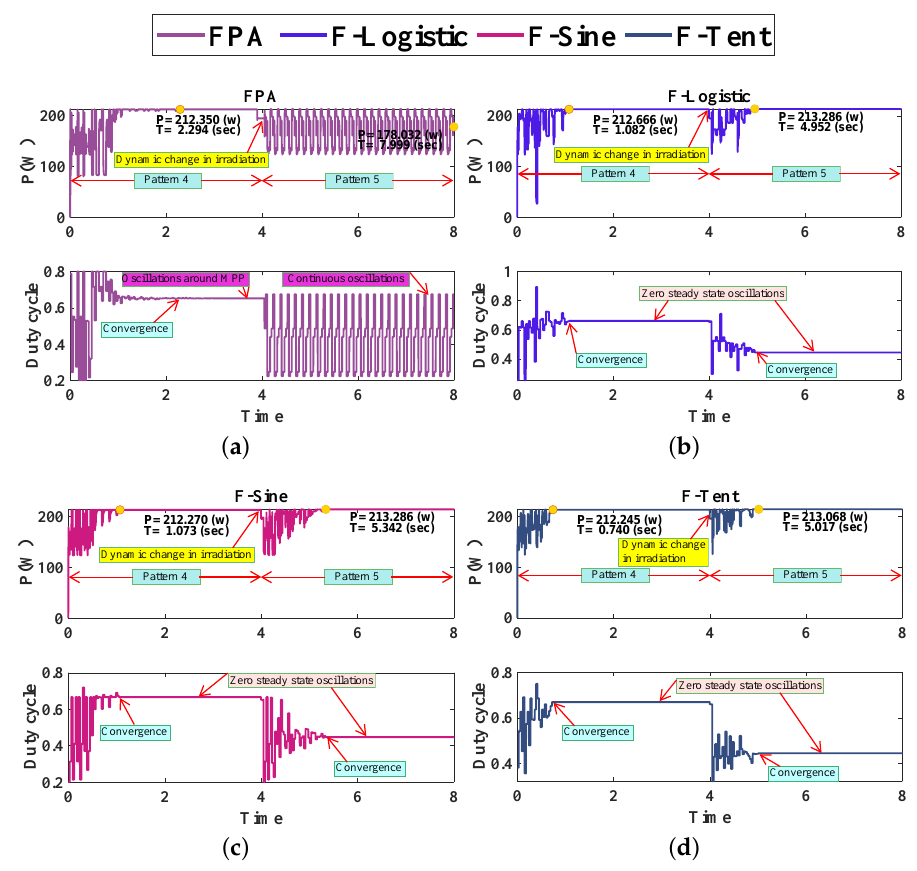
Figure 7. The obtained power and duty cycle by the algorithms over the step changes in irradiance condition from pattern 4 to 5 in the case of 4S2P of SM55 connected PV array: ( a ) FPA, ( b ) F-logistic map with FPA, ( c ) F-sine map with FPA, and ( d ) F-tent map with